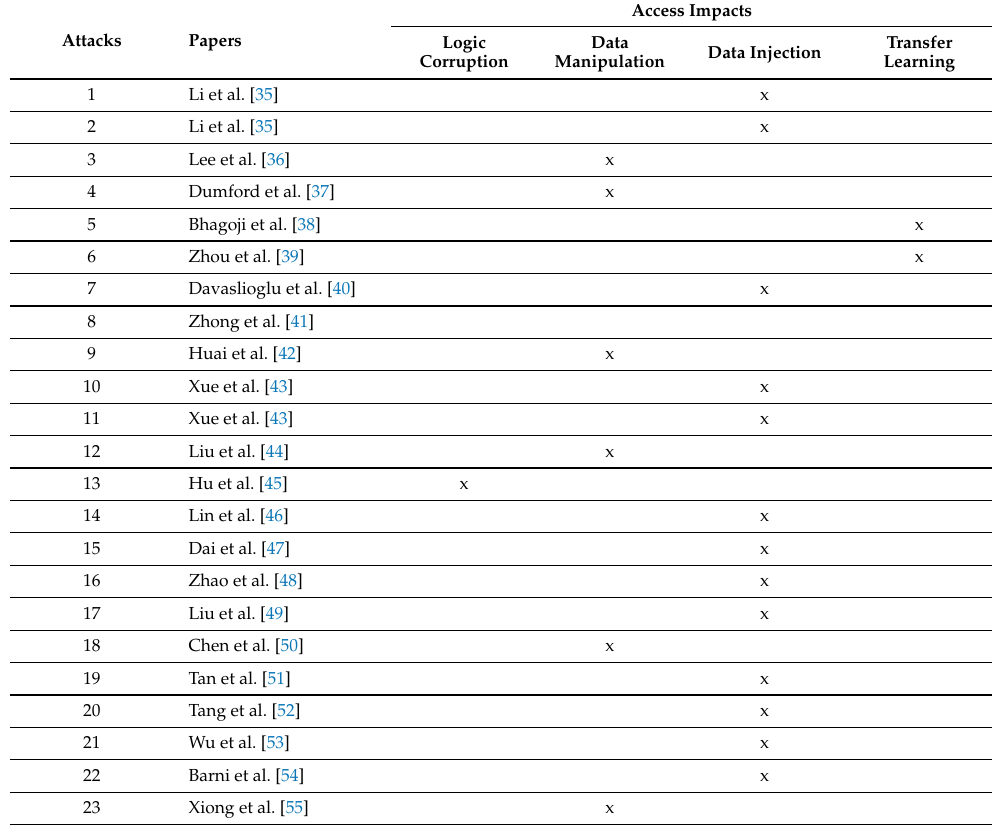
Table 6. A summary of access impacts for each